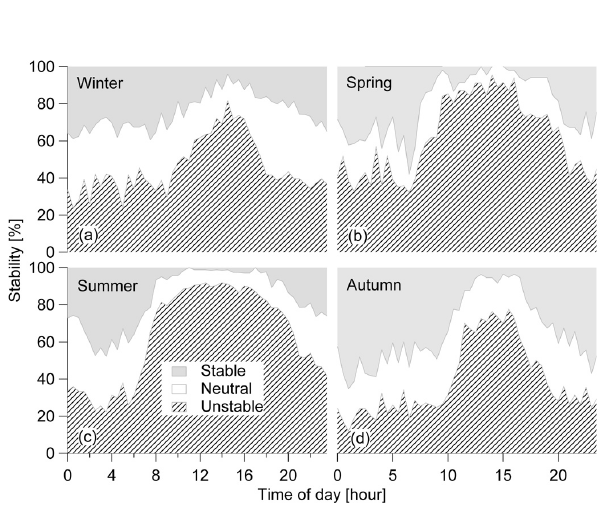
Fig. 2. Frequency distribution of the KM footprint calculated max- imum contribution ( x max ) to the measured CO 2 flux – in 2007, as a function of atmospheric stability for 30min periods ( x max and ζ values denote the beginning of each